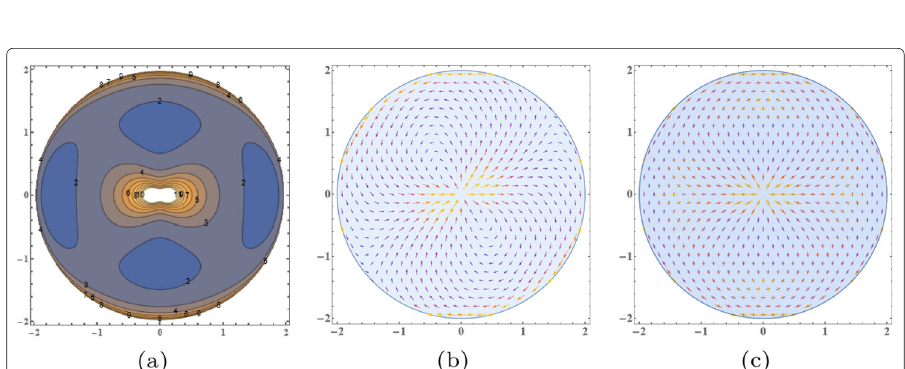
√ Fig. 8 The correlation fields D ( 0,0 ) ( r ) in q ( a ), 1 / 2 ( 1,1 ) · D ( 1,1 ) ( r ) ( b ), and D ( 0,2 ) ( r ) in homogeneous 2 π distributions of loops with preferred alignment in horizontal direction as described in the text. Contours are labeled by function value in ( a ). Length and color of the arrows indicate the magnitude of the vectors, qualitatively, in ( b ) and ( c